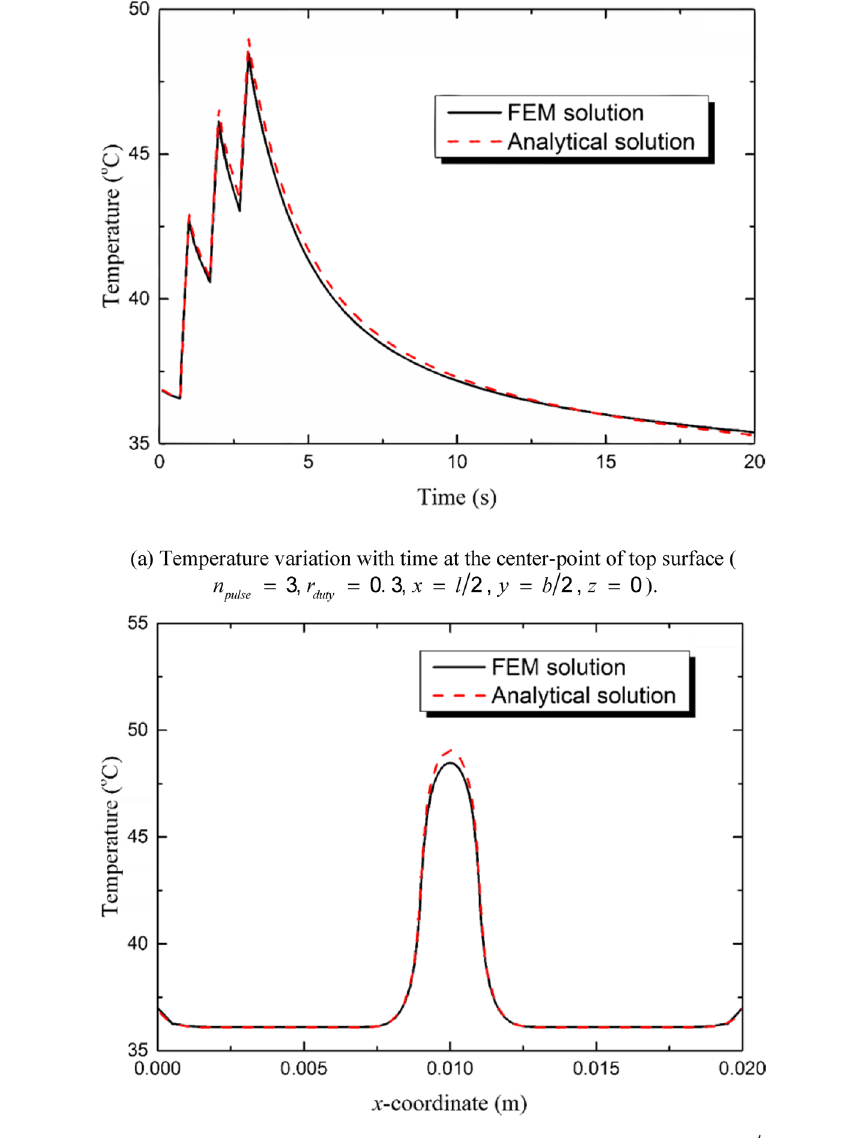
Figure 5. Comparison between FEM and analytical